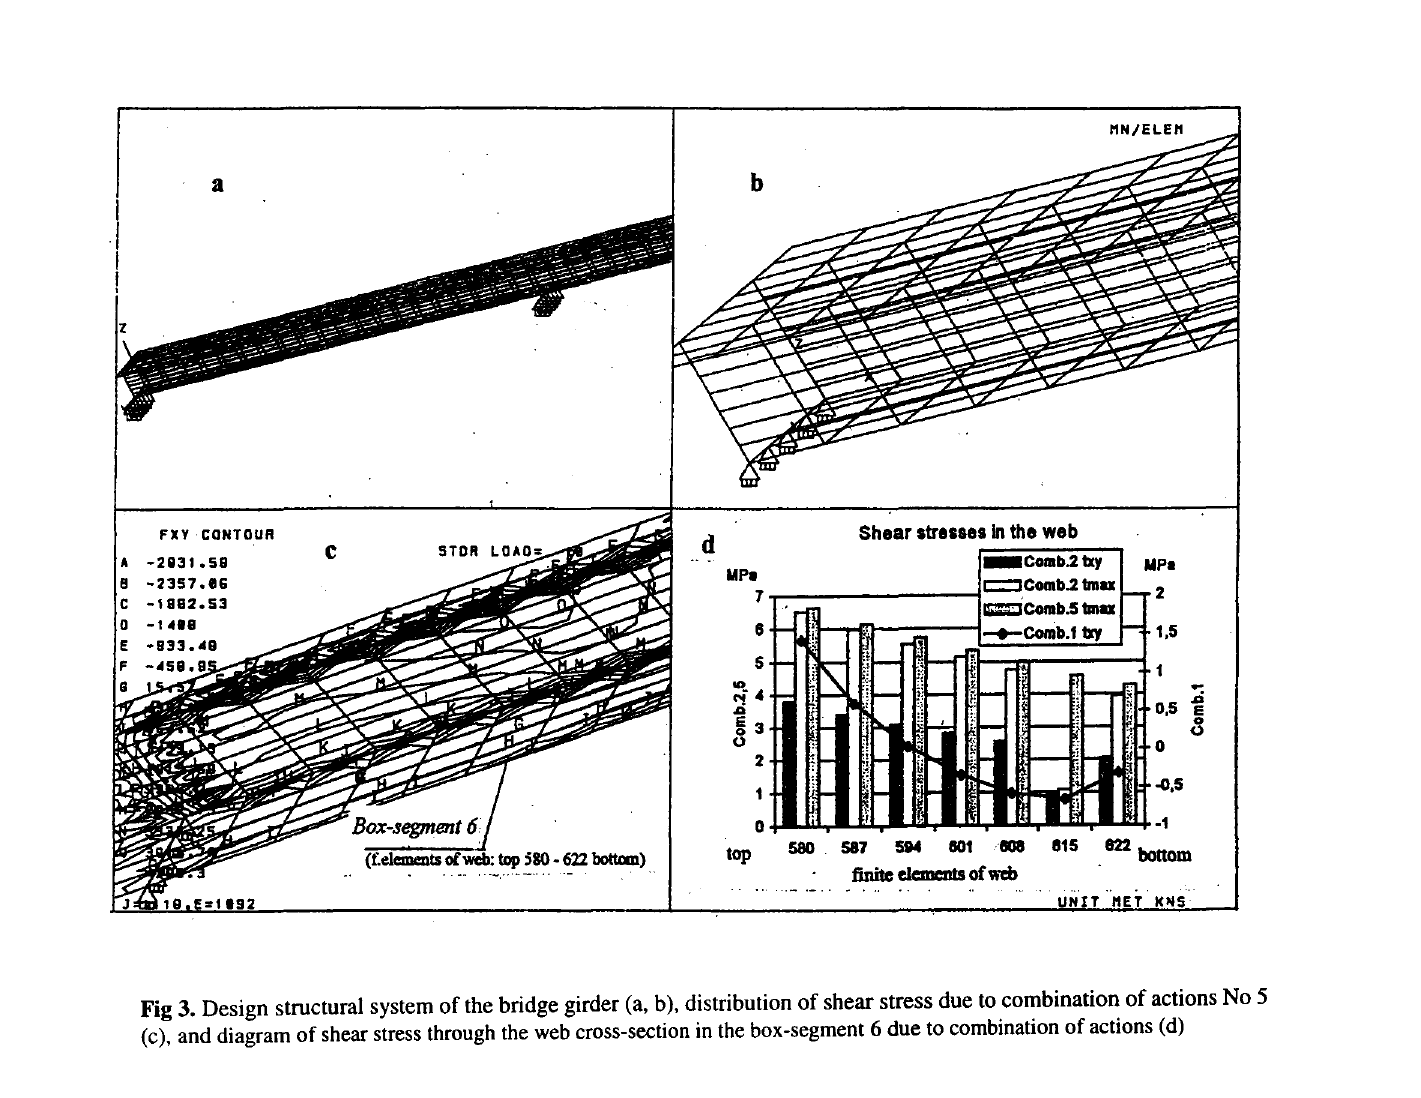
Fig 3. Design structural system of the bridge girder (a, b), distribution of shear stress due to combination of actions No 5 (c), and diagram of shear stress through the web cross-section in the box-segment 6 due to combination of actions